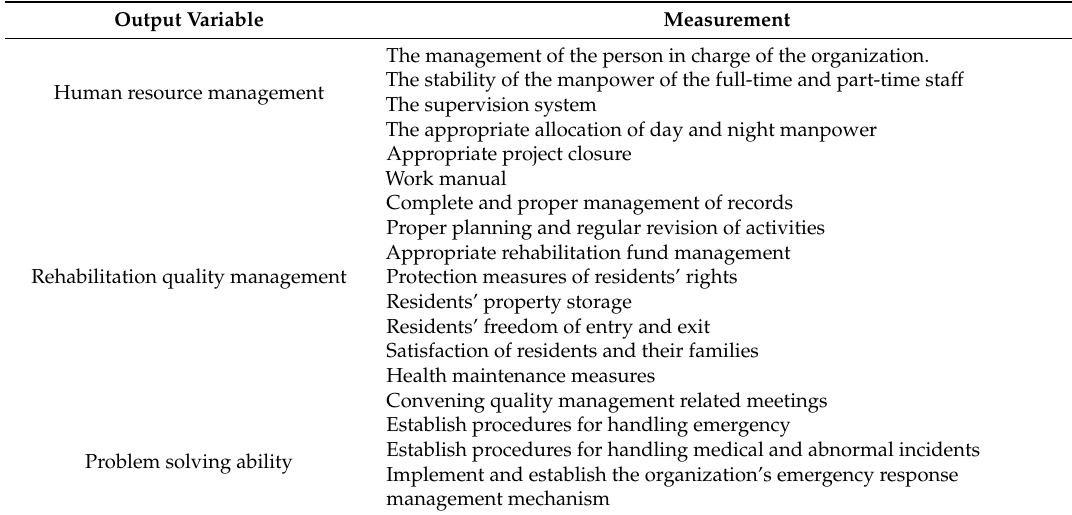
Table 1. Measurements of output